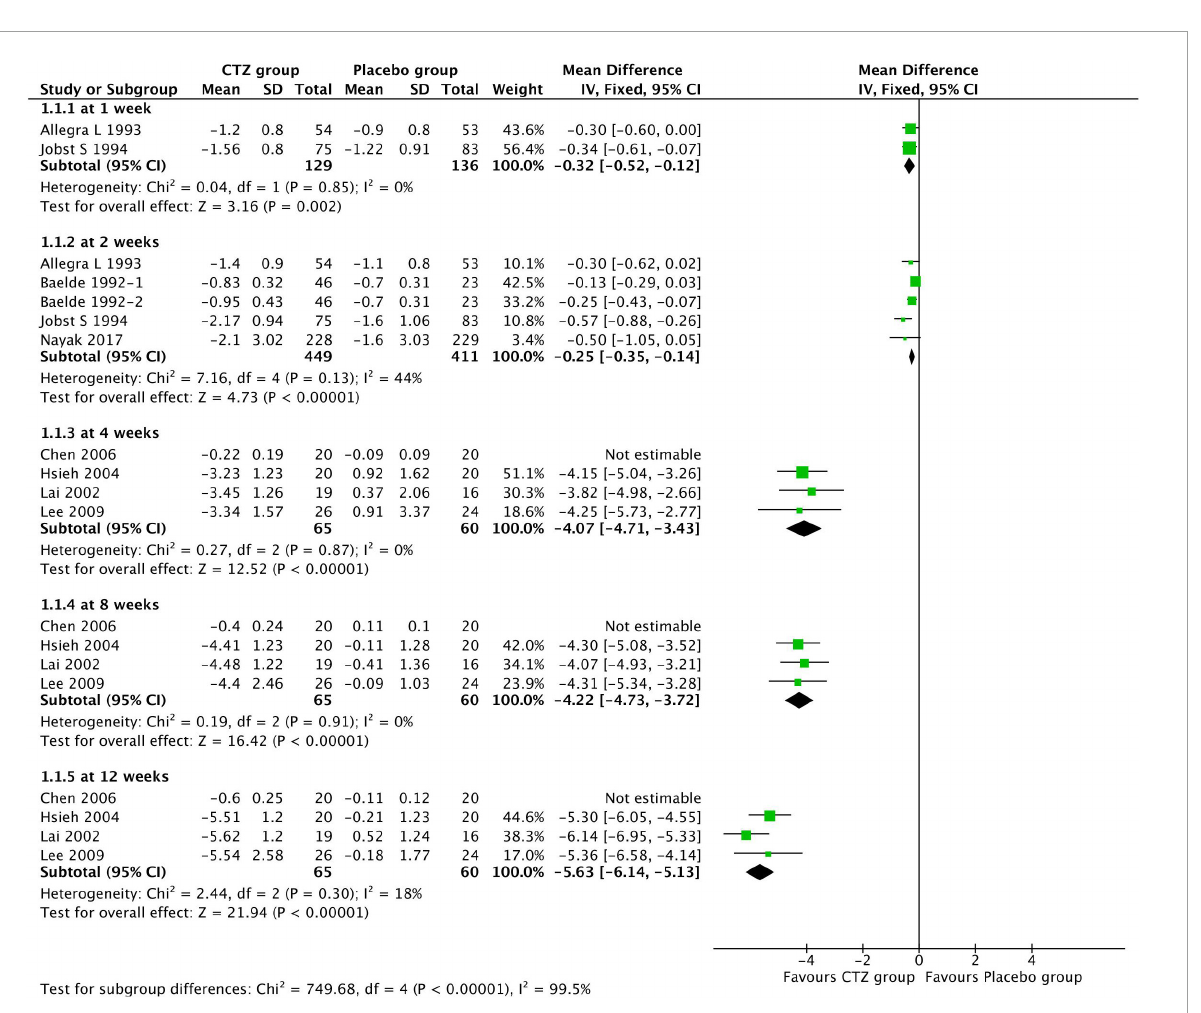
FIGURE4 Comparison of cetirizine with placebo for total symptom score in AR